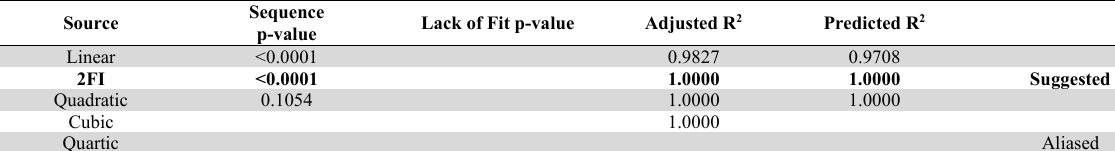
The summary of the selected model of the OEE